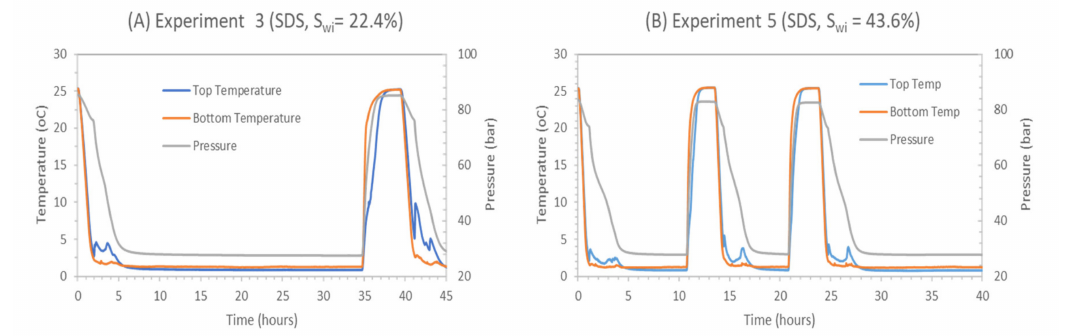
Figure 5. Pressure and temperature profiles for CH 4 hydrate formation under 500 ppm SDS with di ff erent initial solution saturations. ( A ) P-T Profile during methane hydrate formation in the presence of SDS 500 ppm and S wi = 22.4%; ( B ) P-T Profile during methane hydrate formation in the presence of SDS 500 ppm and S wi =